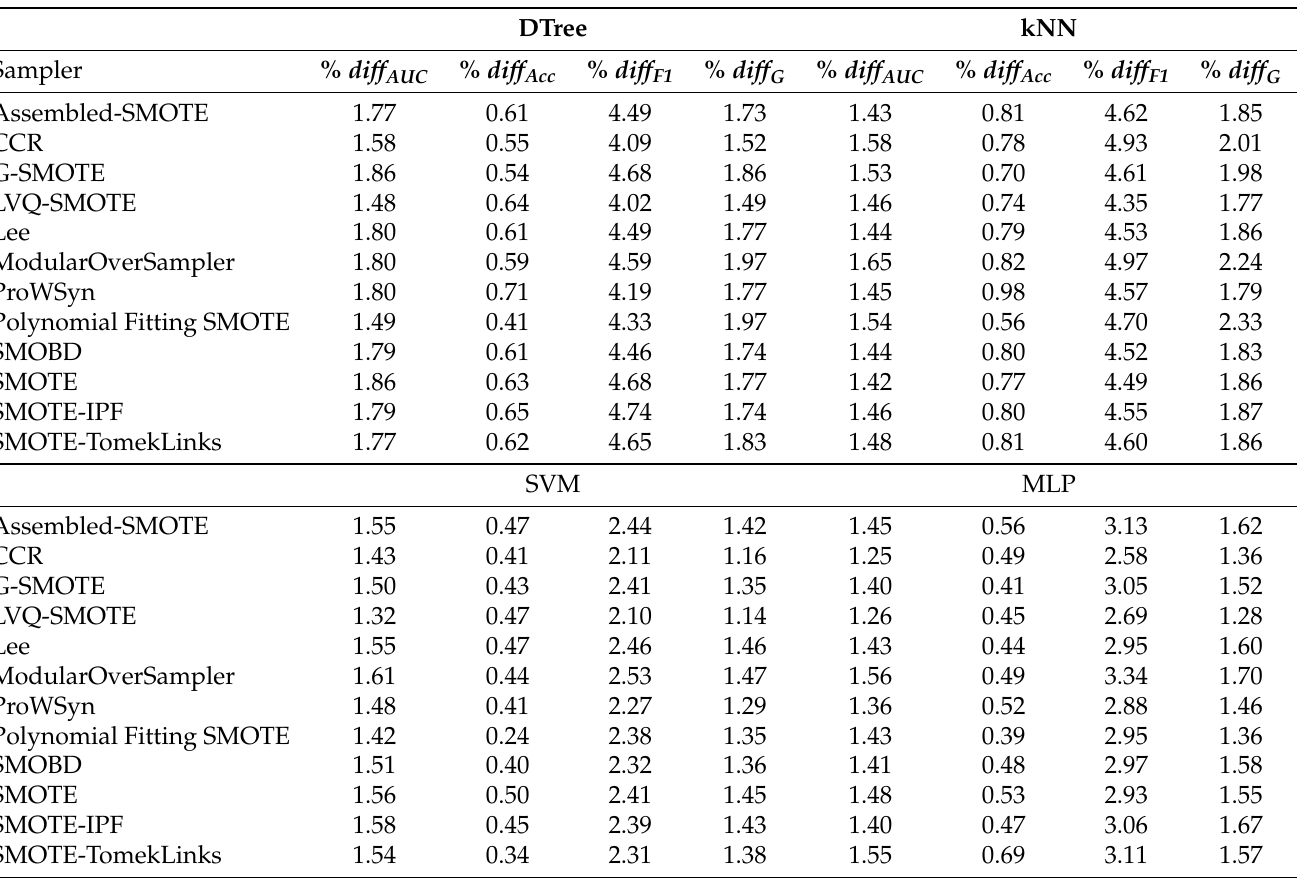
Table A2. Mean of the relative differences of the DOB-SCV and SCV per oversampler on the synthetic data